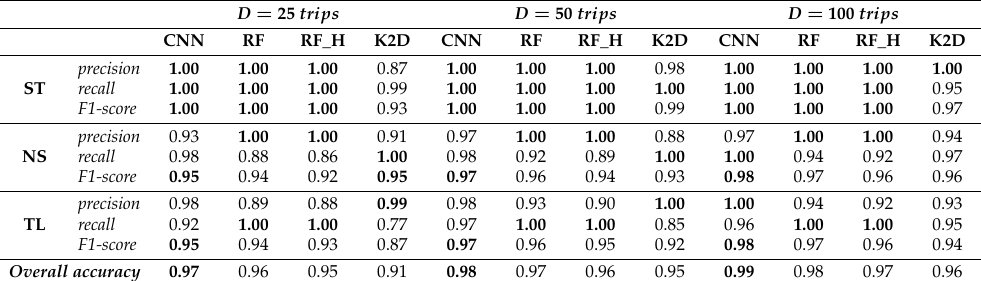
Table 5. Model metrics comparison on the test